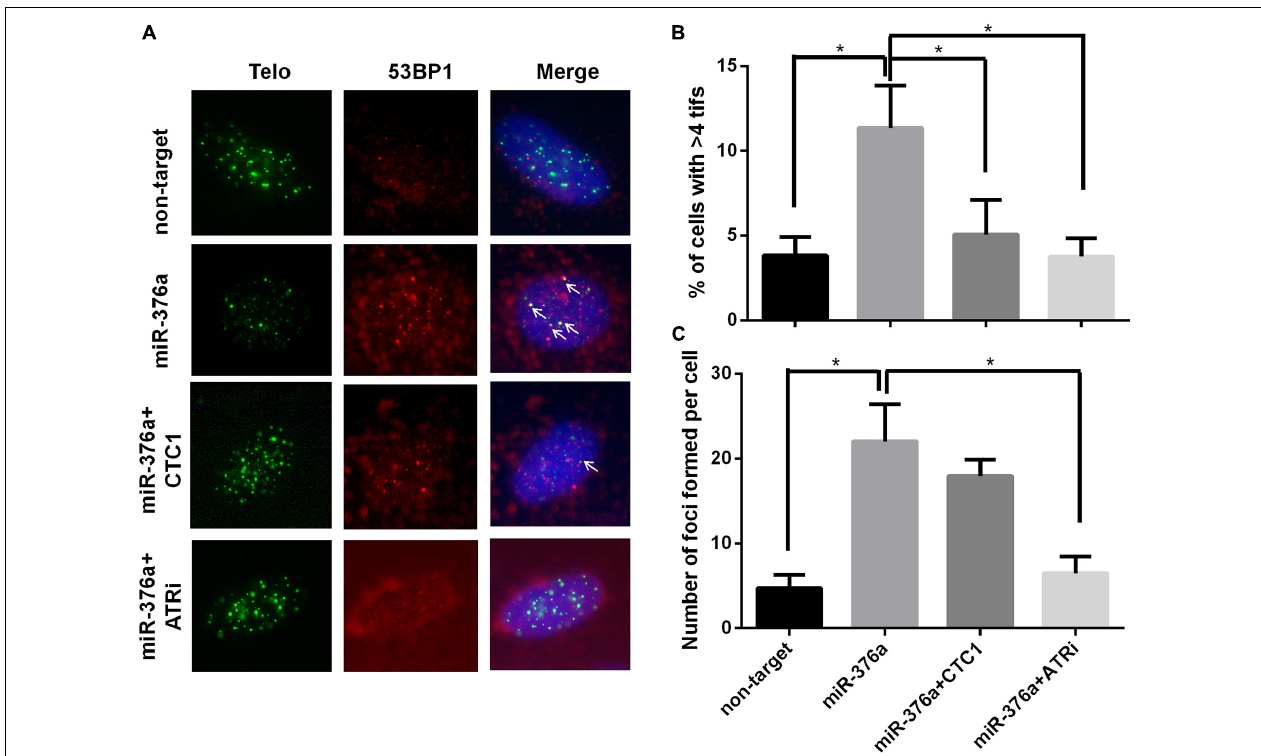
FIGURE 3 | miR-376a leads to telomere damage, which relies on CTC1 expression and ataxia-telangiectasia-mutated-and-Rad3-related kinase (ATR) signal pathway activation. (A) Representative image showing the telomere dysfunction-induced foci (TIFs) on interphase cells with different treatments. TIFs are labeled with white arrows . Telomere ( green ), 53BP1 ( red ), and nuclei were stained with DAPI ( blue ). (B) The percentage of cells with more than four TIFs was calculated. (C) Graph showing the number of 53BP1 foci under different conditions. P values were determined by one-way ANOVA, with * P <